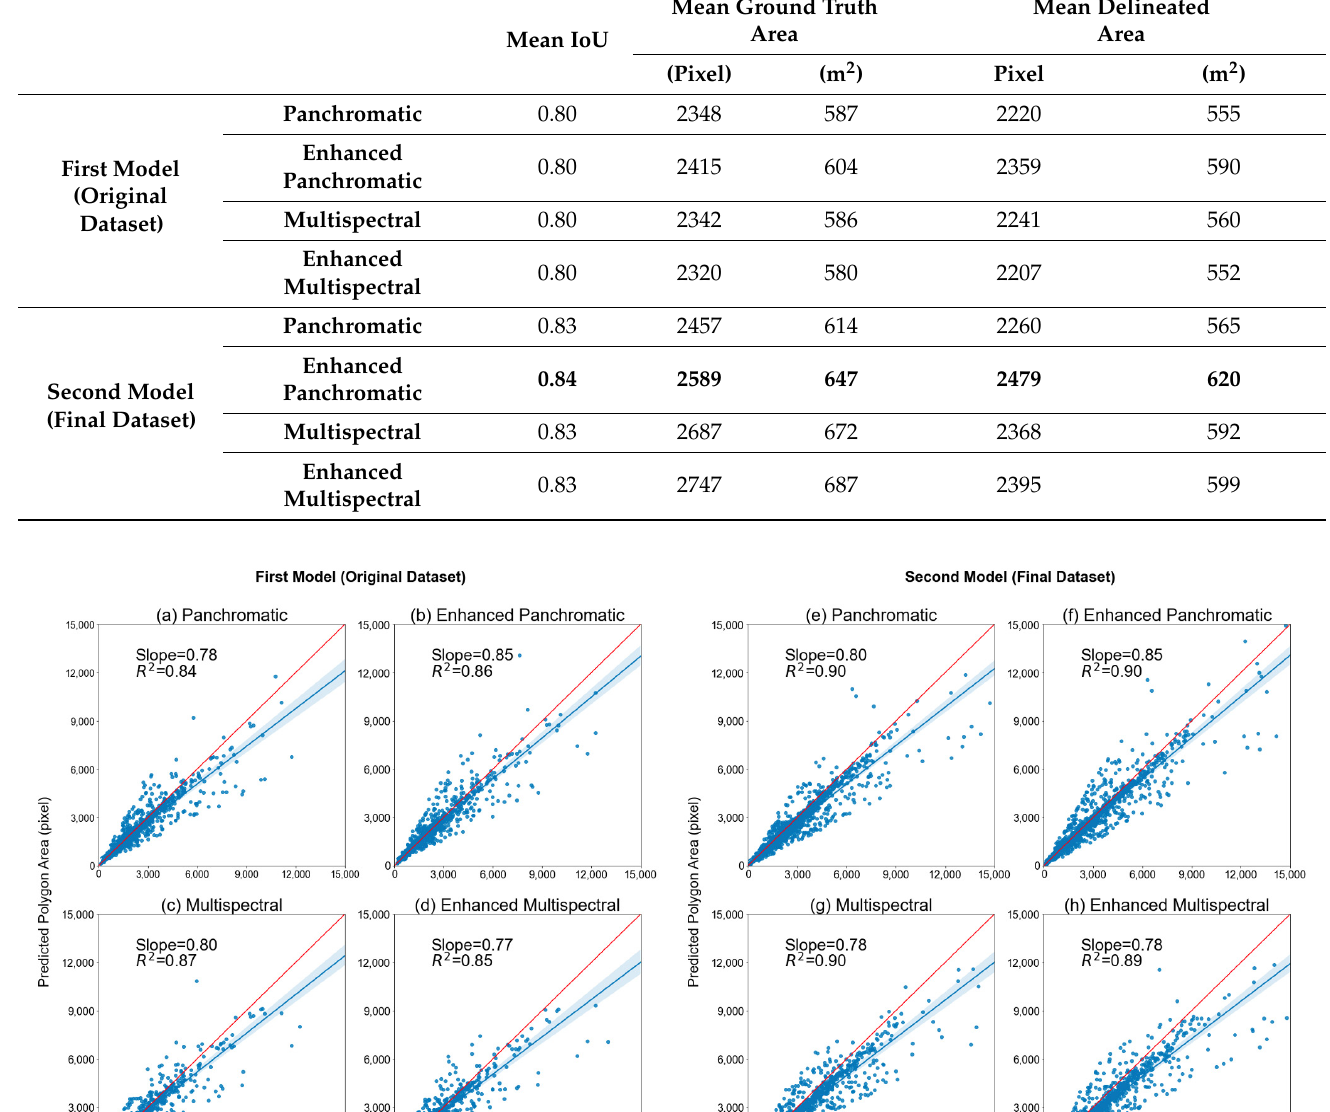
Table 5. Mean IoU, mean ground truth area, and mean delineated field area in Bihar from models trained using WV-3 data in Bihar. Only correctly delineated field masks were included to generate this table. The areas are reported in terms of both the number of pixels and square meters (rounded to the nearest integer). The metrics from the model with the best IoU are shown in bold.